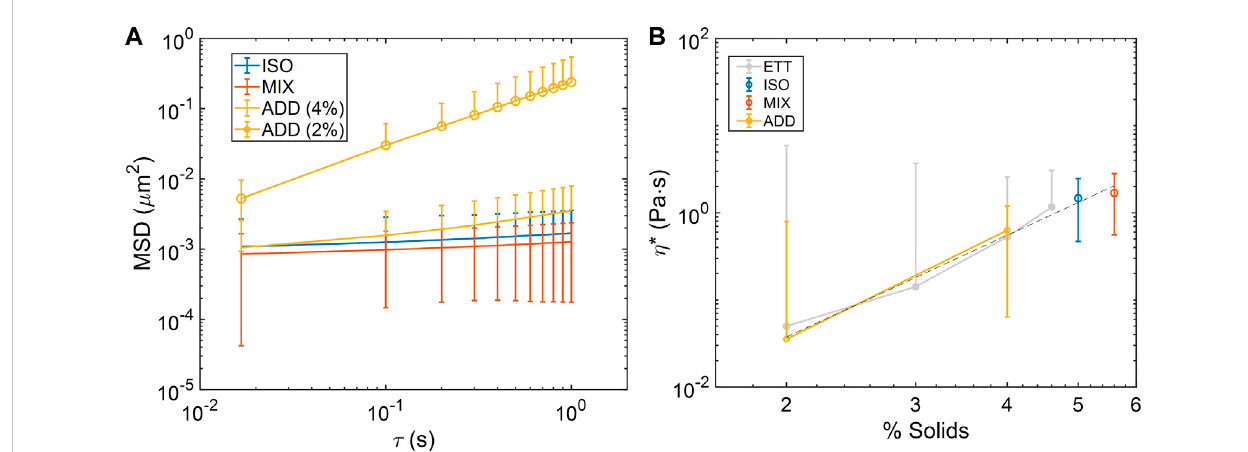
FIGURE 3 Microrheological characterizationof ETT mucus pools. (A) Mean squared-displacement (MSD) curvesof bead diffusion inpooledmucus samples at various concentrations. (B) Complex viscosity ( η *) calculated from MSD in each pool at the examined concentrations follows the power law scaling behavior of η *~c 3.9 (dashed line), which is nearly identical to η *~c 3.8 in previously reported isotonic ETT data (light grey) (Markovetz et al., 2019). Data obtained from n = 3 technical